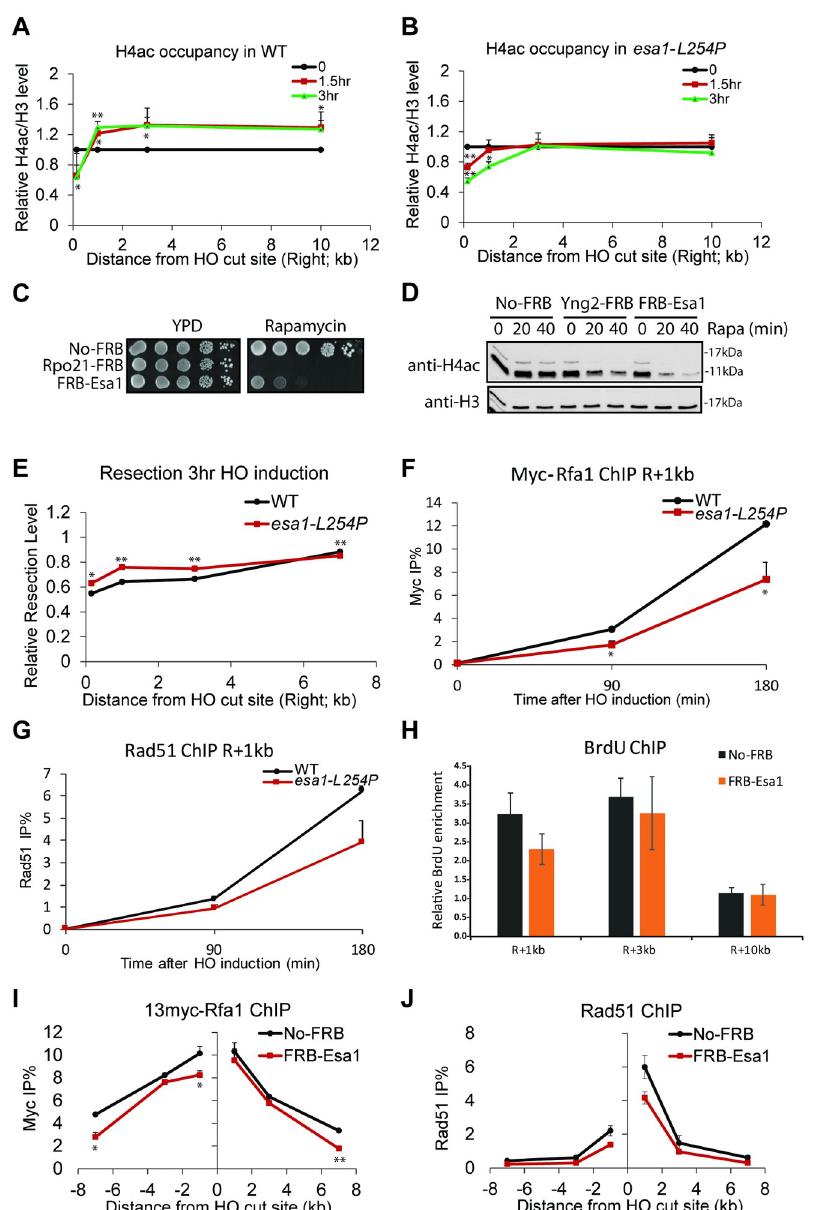
Fig 1. NuA4 is required for H4 acetylation upon DSB induction and affects resection. A-B) ChIP-qPCR of H4ac signal near the DSB site (H4ac/total H3 ratio of %IP/input) in WT and esa1 ts strains during 0, 90 and 180min of galactose induction of HO nuclease. Values at the different locations near the DSB at time 0 was normalized to 1, showing the increase of H4 acetylation upon HO cut in WT conditions but not in mutant at 32˚C (error bars are range of biological replicates). C) 10-fold serial dilutions of indicated FRB-tagged strains were spotted on YPD or YPD containing 1 μ g/ml rapamycin and grown at 30˚C, showing loss of viability by depletion of Esa1 and RNA PolII largest subunit for comparison (Rpo21). D) WB of WCE from indicated strains treated with 1 μ g/ml rapamycin for 0, 20 or 40min, showing loss of H4 acetylation by depletion of Esa1 and Yng2, another subunit of NuA4 (not used further as it affects Gal induction). E ) Resection assay of WT and esa1-L254P cells after 3hr of galactose induction at 32˚C. DNA content around the break was measured by qPCR with genomic DNA and normalized on uncut locus (interV), showing higher level of DNA remaining near the DSB in mutant cells. F-G) ChIP-qPCR assay of 13myc-Rfa1 (F) and Rad51 (G) next to the DSB site in WT and esa1-L254P after 0, 90 and 180min of HO induction at 32˚C, showing less accumulation in mutant conditions. H) ChIP-qPCR assay of BrdU in No-FRB and FRB-Esa1 strains after 3hr of galactose induction in presence of rapamycin, showing slightly less exposed ssDNA near the break after Esa1 depletion. BrdU enrichment was normalized on control locus (interV). I-J) ChIP-qPCR assay of 13myc-Rfa1 (I) and Rad51 (J) in